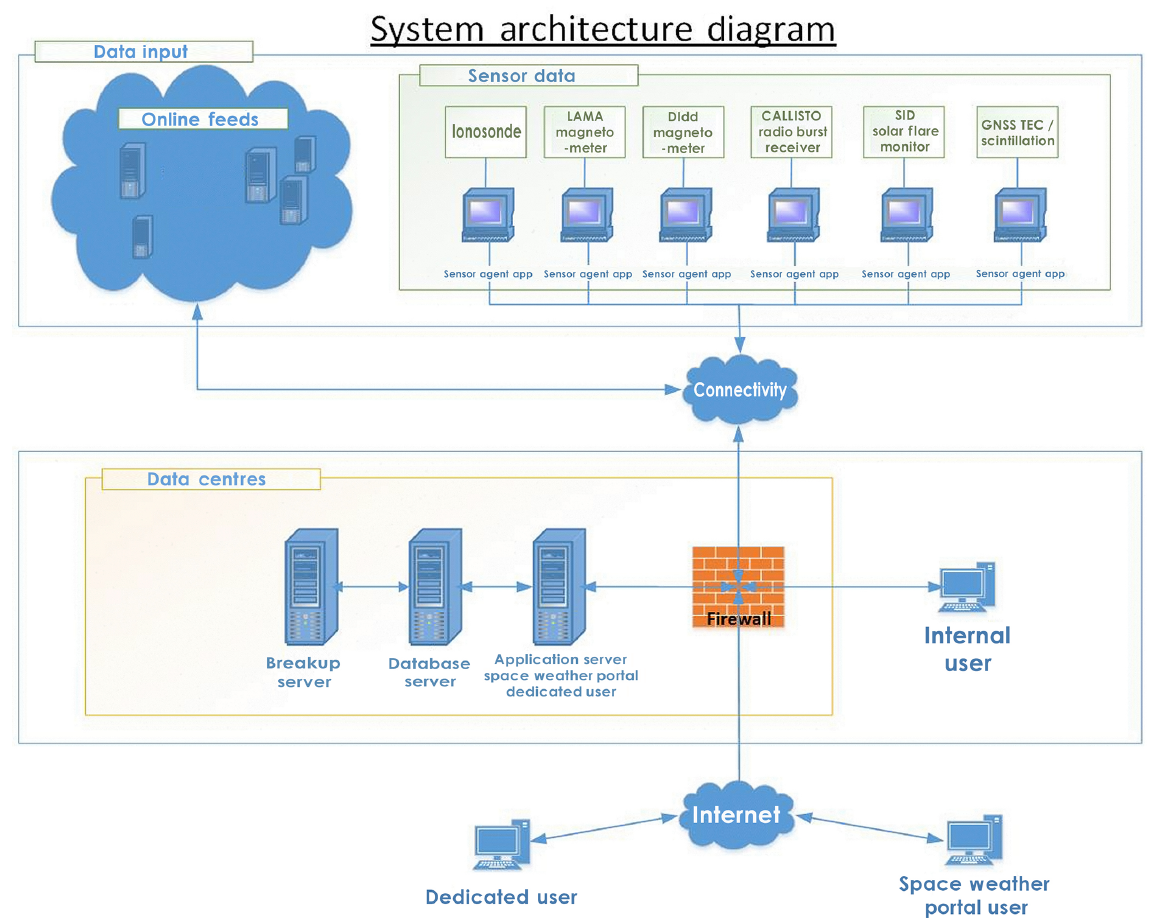
Figure 13. Overview of the integrated monitoring system developed as a part of the project.